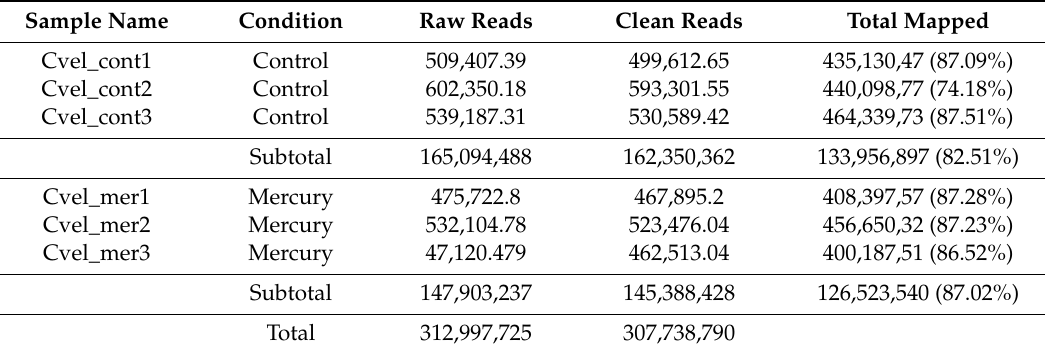
Table 1. Summary of the sequencing